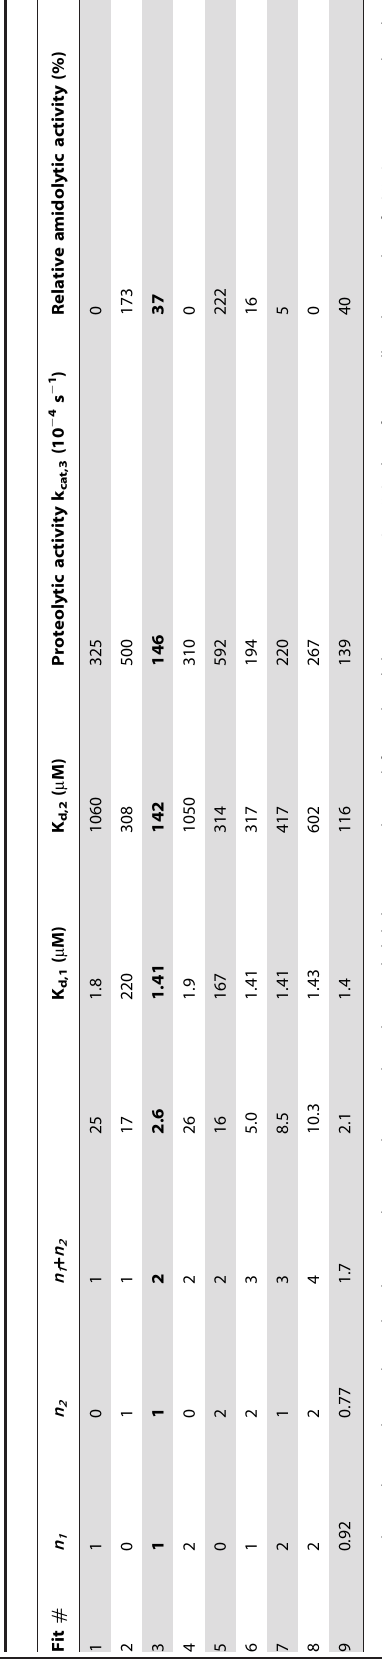
Figure 6. Simultaneous fit of functional and structural changes of FIXa versus concentration of soluble C6PS. Frame A plots results ( D P as defined in File S1 versus C6PS concentration) of three independent equilibrium dialysis experiments performed at both 20 m M (closed circles) and 25 m M (open squares) of total FIXa. Frames B to E reproduce data from Figures 1 and 3, but with lines obtained as described in File S1. All data shown in Frames A to E of this figure were fitted globally by adjusting only K 1 , K 2 , n 1 , and n 2 (see File S1). The best fit for n 1 and n 2 as natural numbers was obtained for n 1 ,=n 2 =1 (Fit # 3) and is shown as solid black lines. Allowing n 1 , and n 2 to be real numbers (0.92 and 0.77, respectively) provided a fit that was statistically only slightly improved (; red lines. The next best fit ( # 6) was obtained with n 1 =1 and n 2 =2, but clearly was both numerically and visually (blue lines) much worse. Fits with other stoichiometries were even worse (Table 2). Frame F plots predicted FIXa species as calculated using parameters from Fit # 3- (Table 2) and the model described in File S1 as a function of C6PS concentration.